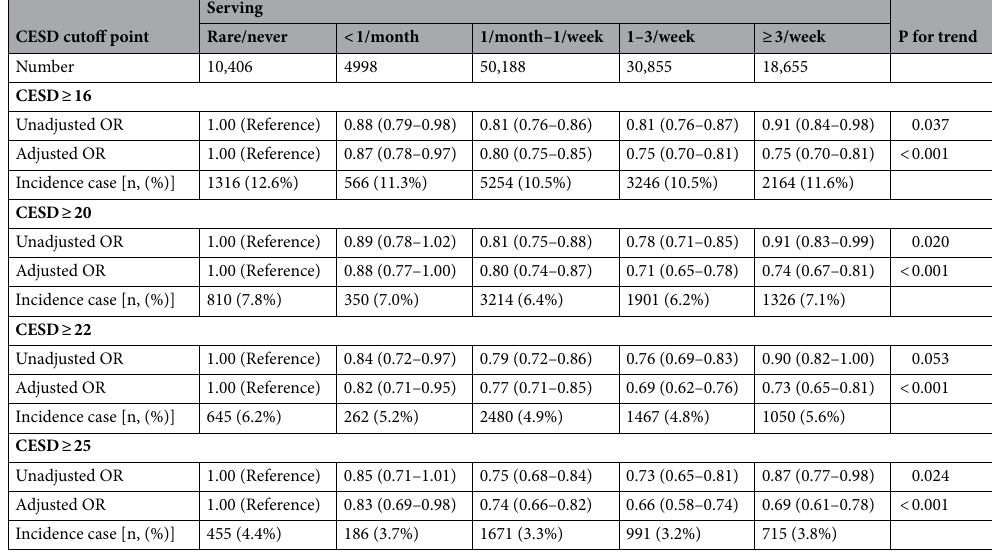
Table 4. Odds ratio (OR) and 95% confidence intervals (CI) for depressive symptom (CESD ≥ 16, 20, 22, 25) according to the baseline mushroom consumption. Adjusting covariates: age, BMI, sex, alcohol intake, hypertension, diabetes, smoking, marital status, education, and total calorie intake. < 1/month < one serving size/month, 1/month–1/week one serving size/month ≤ ~ < one serving size/week, 1–3/week one serving size/ week ≤ ~ < three serving sizes/week, ≥ 3/week ≥ three serving